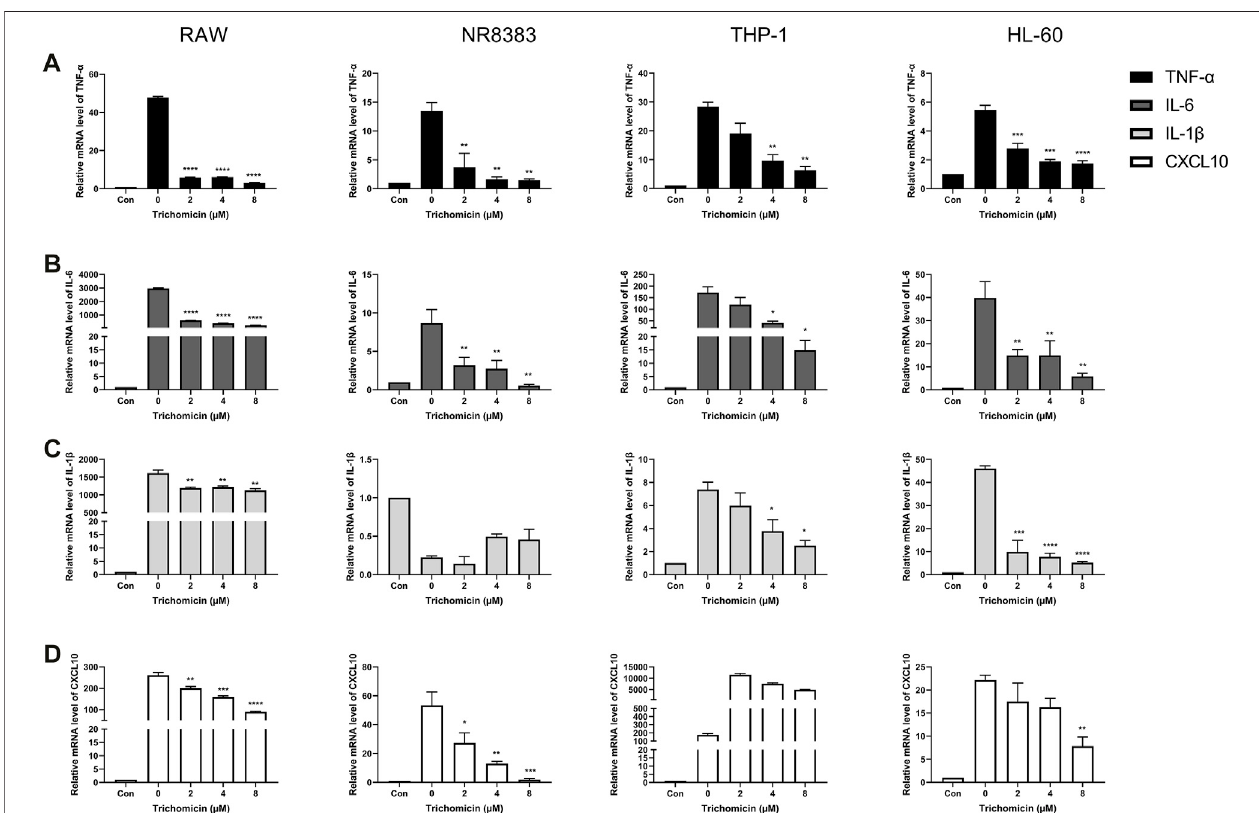
FIGURE 3 | Trichomicin inhibits the expression of TNF- α , IL-6, IL-1 β , and CXCL10 in macrophages. RT-PCR quantitation of TNF- α (A) , IL-6 (B) , IL-1 β (C) and CXCL10 (D) mRNAexpression in RAW, NR8383, THP-1, and HL-60cells stimulated with LPS(100 ng/ml) following treatment with2,4, and 8 µM Trichomicin.(mean ± SD, n (cid:1) 3). * p < 0.05, ** p < 0.01, *** p < 0.001, **** p < 0.0001 vs. LPS-induced